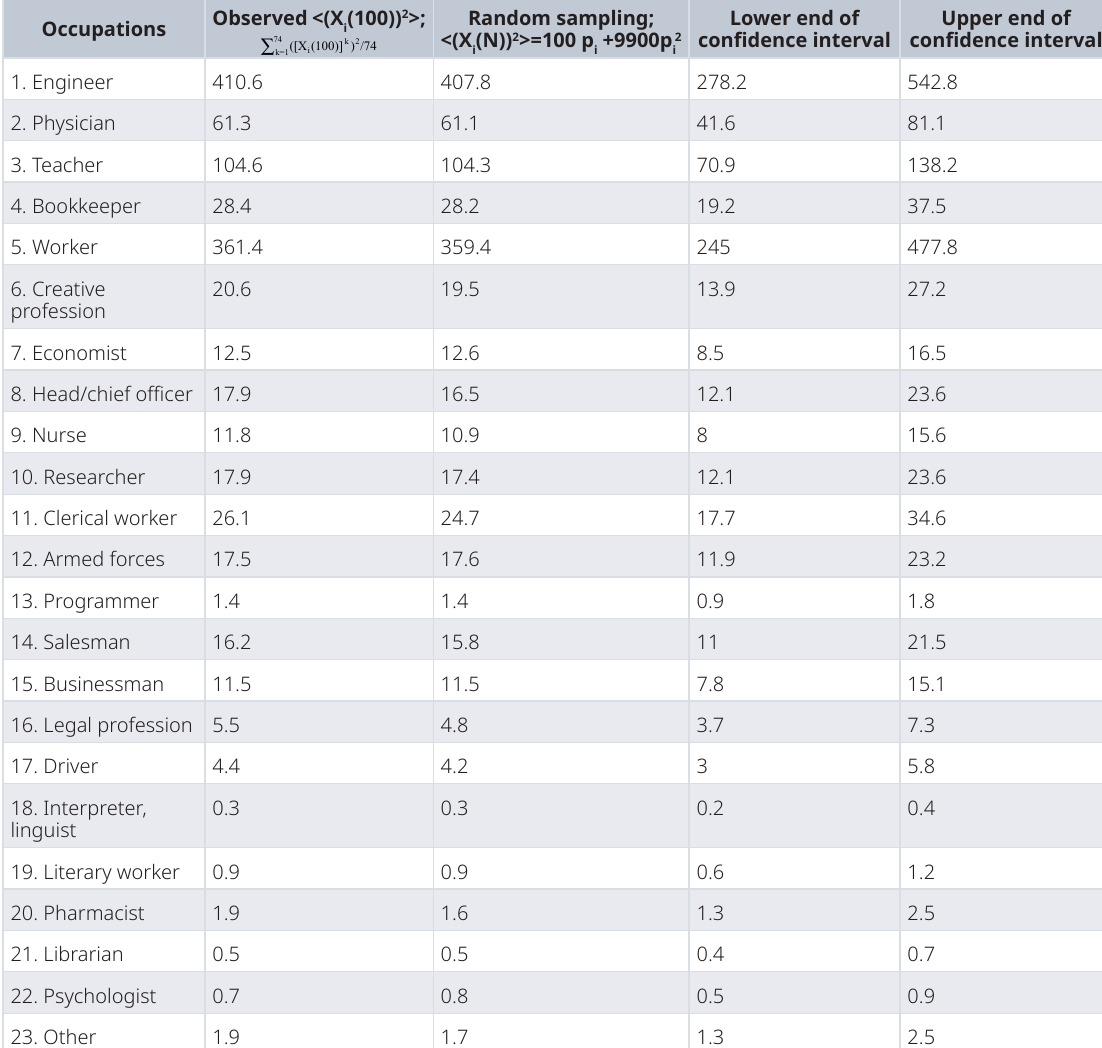
Table 4. Comparison of dispersion evaluated from the sample data (second column) and the random sampling prediction (third column) for generic surnames. The agreement is found to be much narrower than allowed by the confidence interval provided in the fourth and fifth